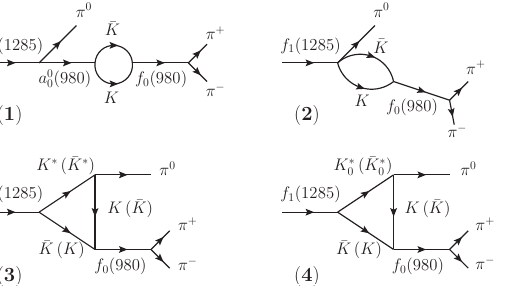
Figure 5. We have analyzed in detail four possible K ¯ K loop mechanisms [18] shown in this figure for the isospin breaking decay f 1 (1285) → π + π − π 0 . We point out that existing data [6, 14] should be more precise, and they are di ffi cult to explain by the single specific mechanism from those listed here.